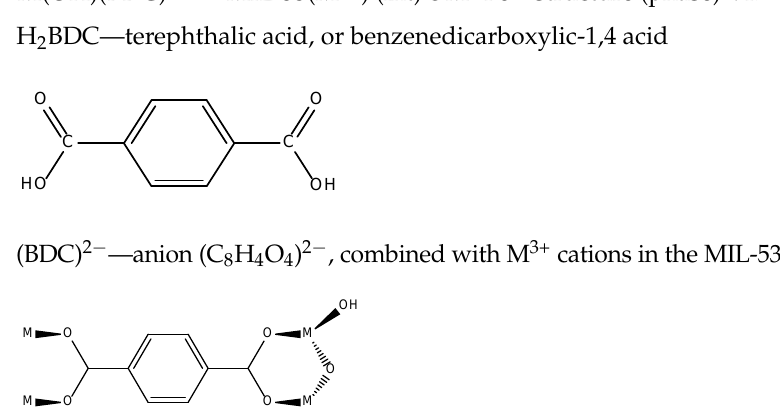
(BDC) 2 − —anion (C 8 H 4 O 4 ) 2 − , combined with M 3+ cations in the MIL-53(M 3+ ) structure